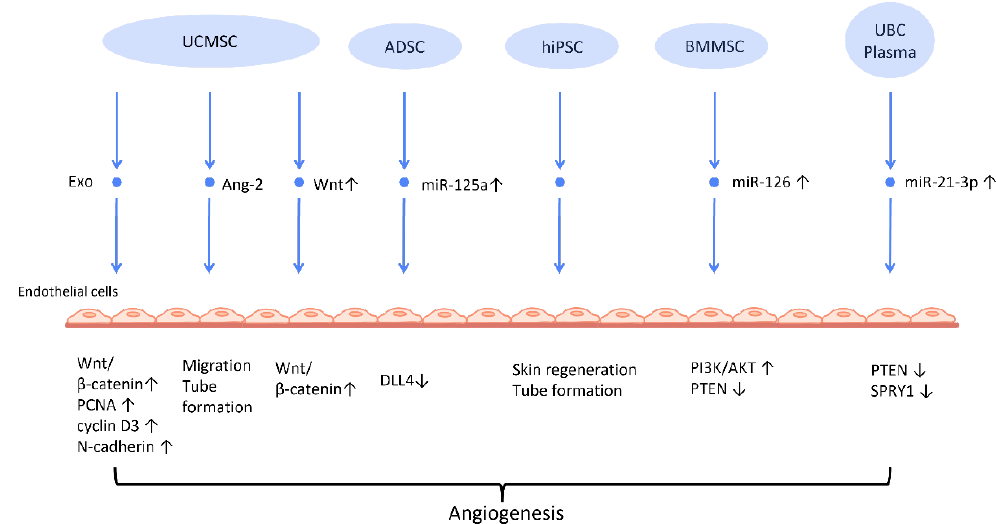
Figure 2. Molecular mechanisms of stem cell-derived exosomes in stimulation of angiogenesis. Stem cell-derived exosomes facilitate neovascularization by transmitting various angiogenic factors or miRNA to endothelial cells, leading to increased proliferation and migration of endothelial cells.